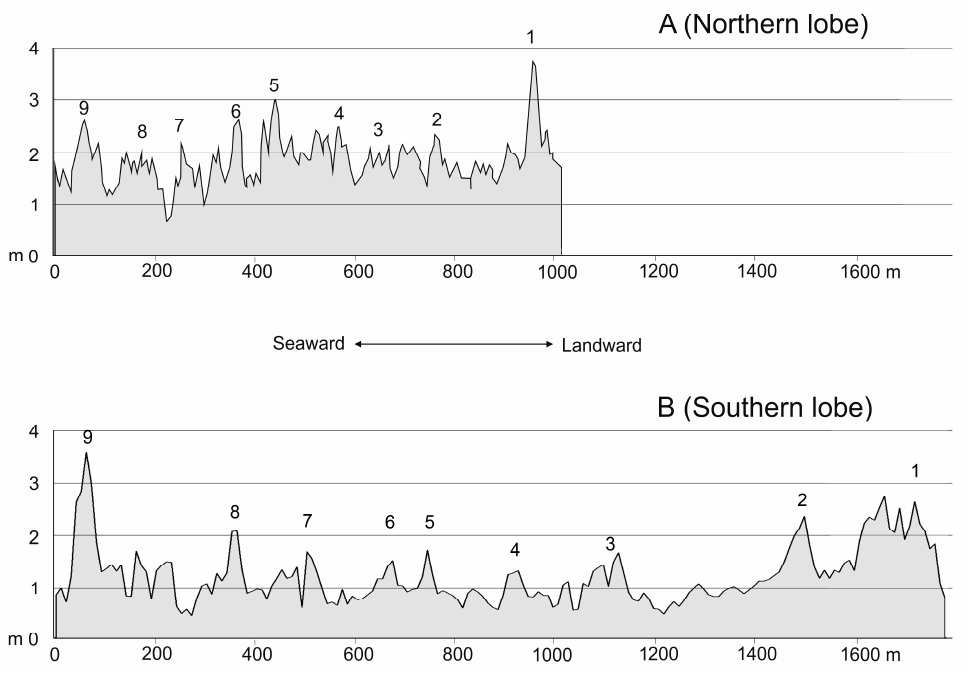
Figure 3. North ( A ) and south ( B ) profiles from the early 15th (1) century until the limit of the progradation in middle 19th century (9). Due to the difference in deposition rates, horizontal scale cannot be considered a time